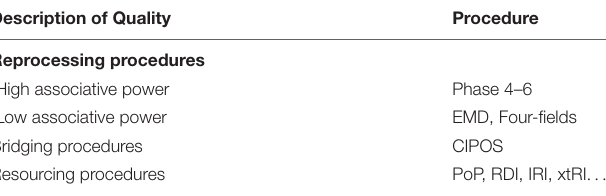
TABLE 1 | Procedures in EMDR therapy.